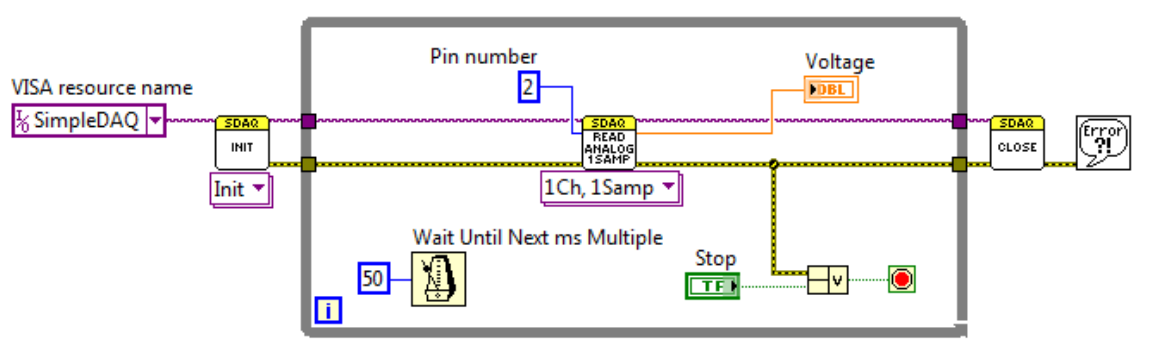
Figure 11. Acquisition of single sample using a software